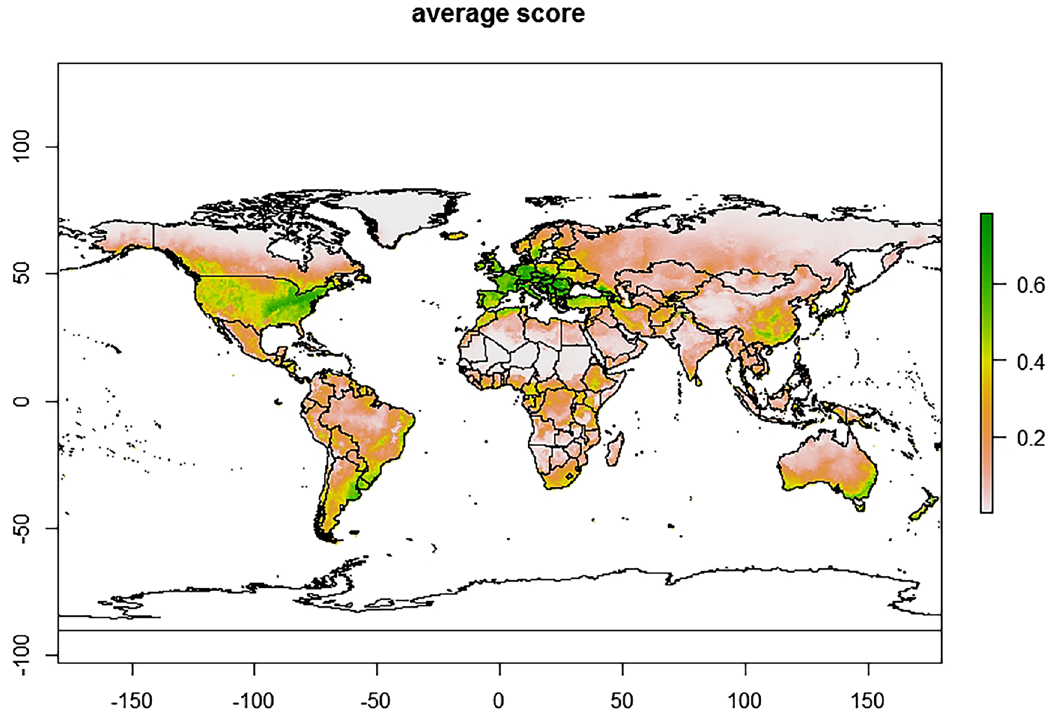
Figure 6. Maxent and BIOCLIM average model plots depicting current establishment of Trialeurodes vaporariorum with an establishment risk index (ERI) > 0.6 in Europe, Central America, parts of Southern America (Brazil, Uruguay and Argentina), parts of Australia, New Zealand and Asia (China and Japan).